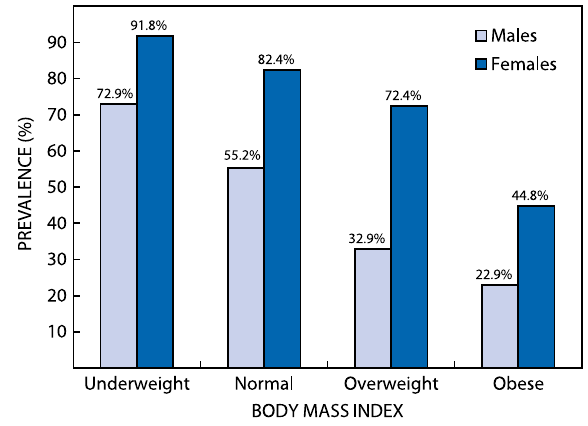
Figure 2: Body mass index by prevalence of